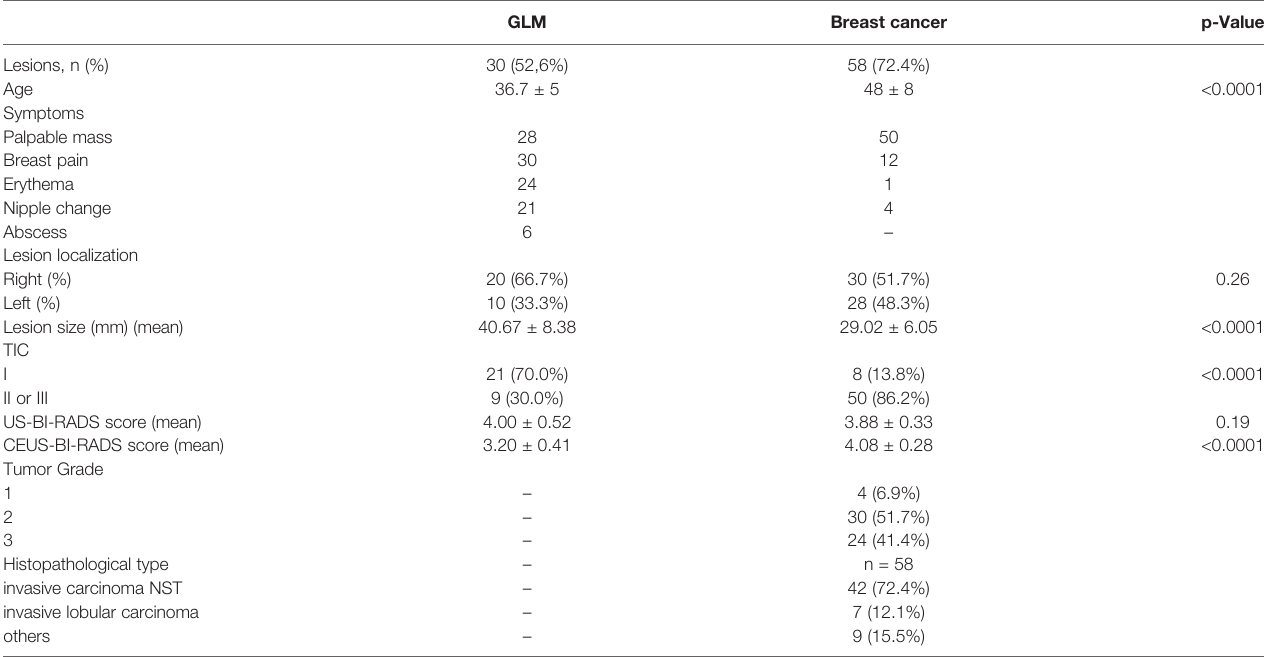
TABLE 1 | Basic patient and lesion characteristics.